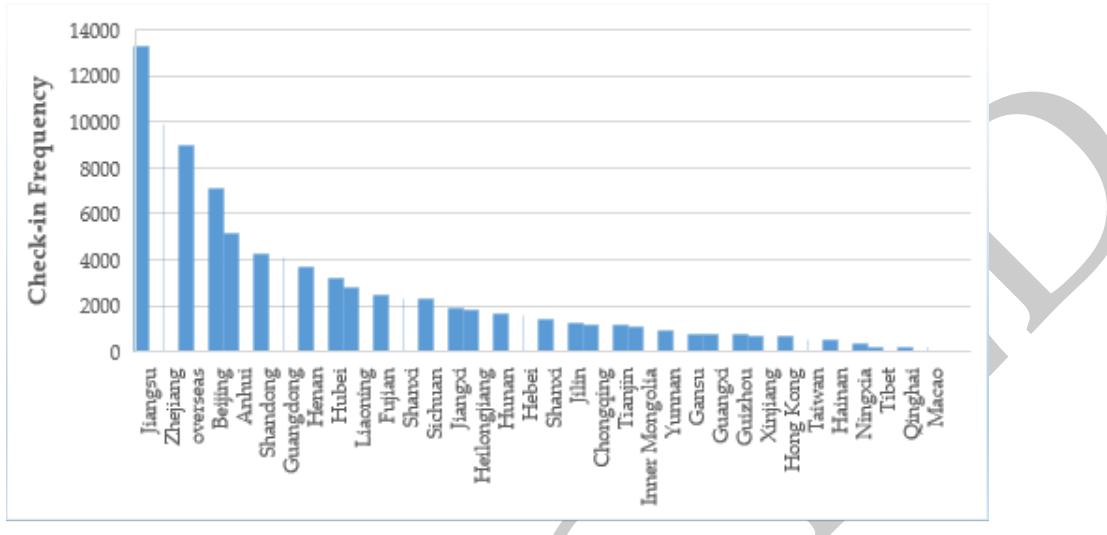
Figure 3. Frequencies of tourists’ check-in from different provinces.